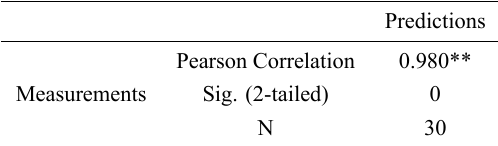
Table 4. Correlation analysis.